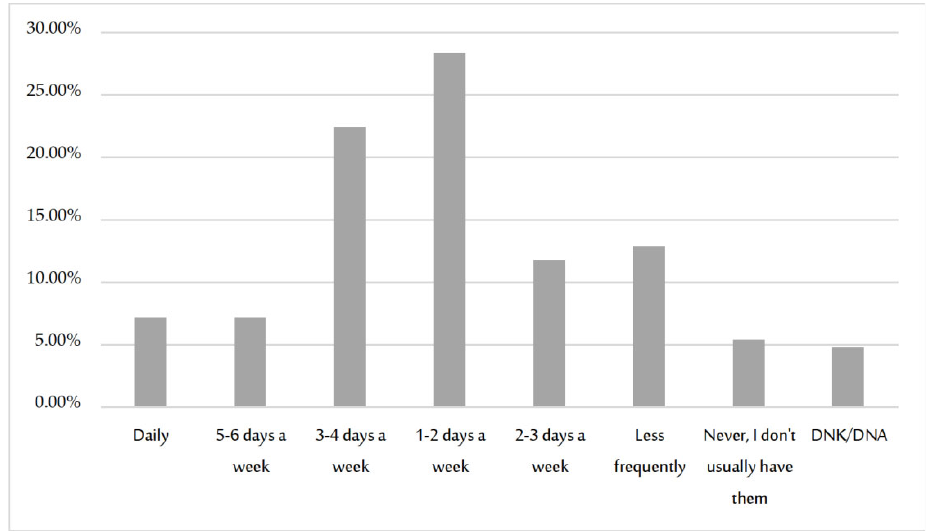
Figure 2. Frequency of sexual relationships.